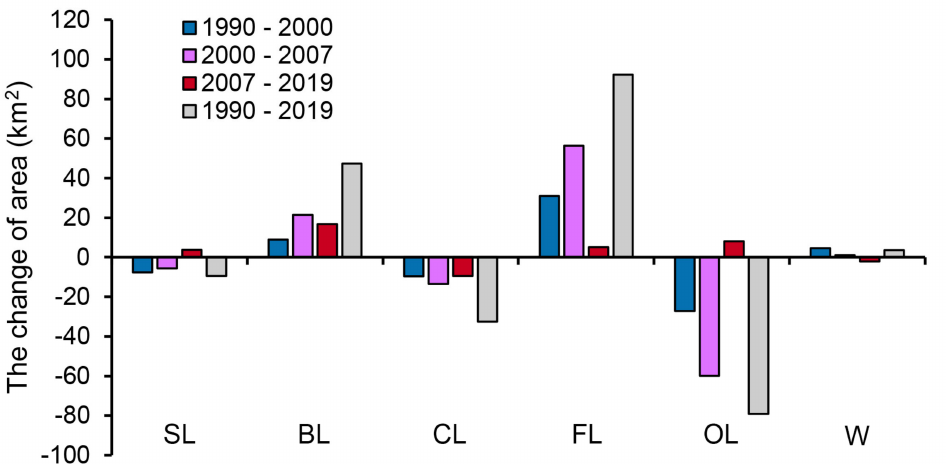
Figure 4. The change in the area of land cover classes in di ff erent time intervals: 1990–2000, 2000–2007, 2007–2019, and 1990–2019. SL = sandy land, BL = built-up land, CL = cultivated land, FL = forest land, OL = other land, W = water.